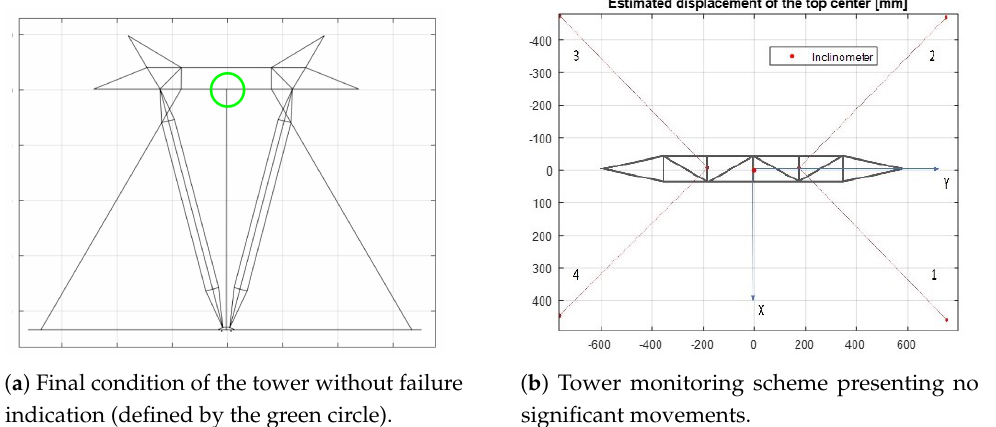
Figure 29. Schematic images of the tower for the status indication at the end of the failure simulation. Note: tower draft drawing without